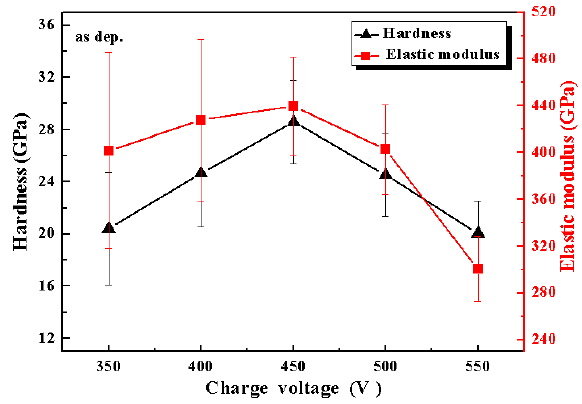
Figure 6. The hardness and elastic modulus of AlCrN coatings deposited at different charge